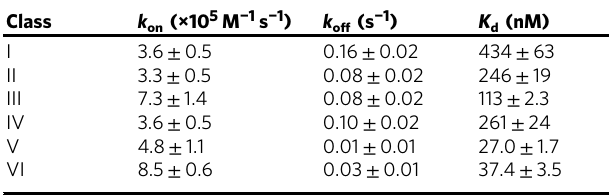
Table 3 Surface plasmon resonance-binding data for the interaction between the six HCoV-229E RBDs and hAPN